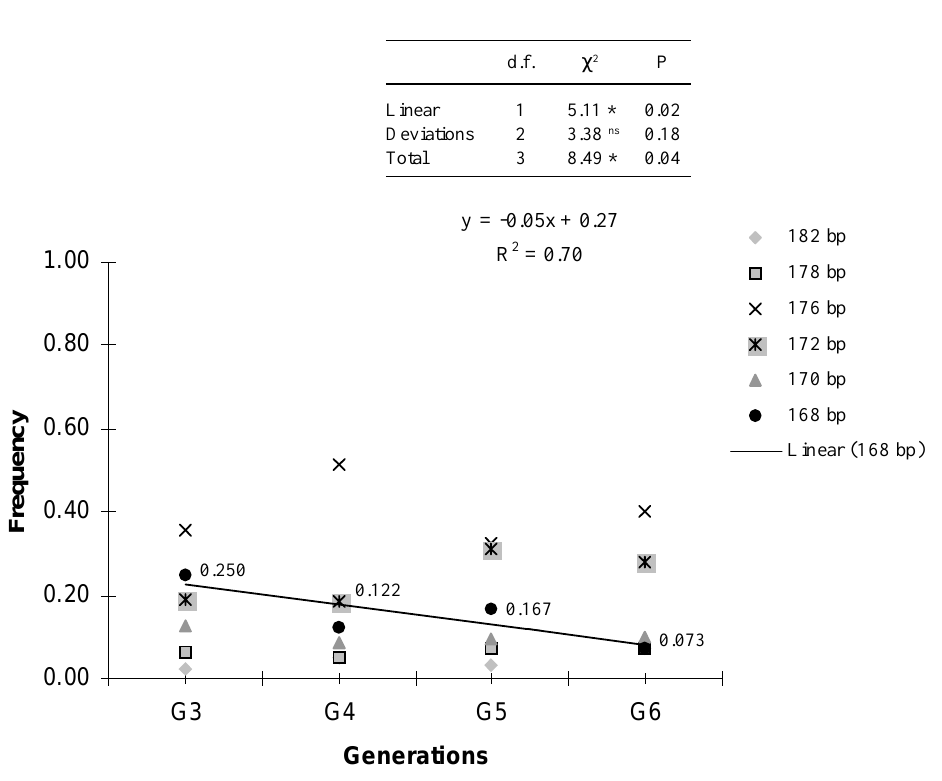
Figure 3 - Frequency variation of microsatellite CSFM50 alleles over different generations of Canchim cattle. Results of chi- square analysis are shown on the top right of the figure. ns and *: Nonsignificant and significant at P < 0.05, respectively.